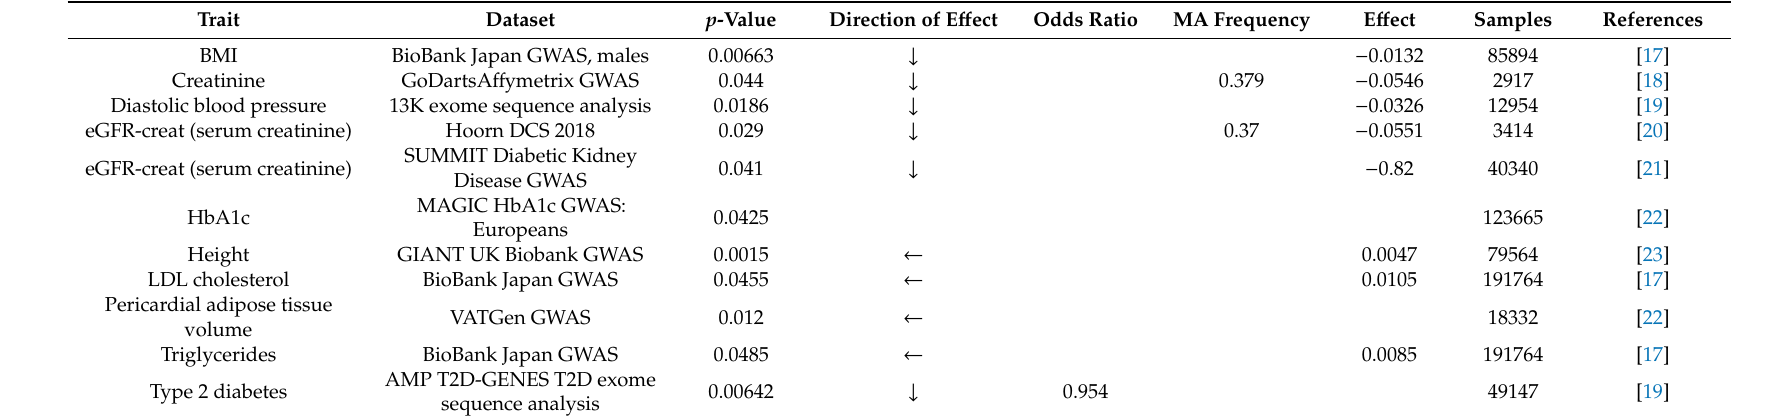
Table 7. Association of rs319013 across all datasets and traits included in the Type2Diabetes knowledge Portal.